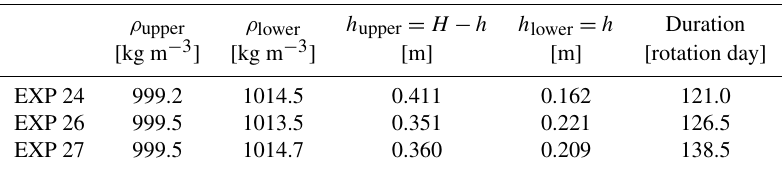
Table 1. Initial conditions of the two layers, density ( ρ upper and ρ lower ) and thickness ( h upper and h lower ), and the experiment duration. Note that one revolution takes 120s, i.e., 1 rotation day. H is the total water